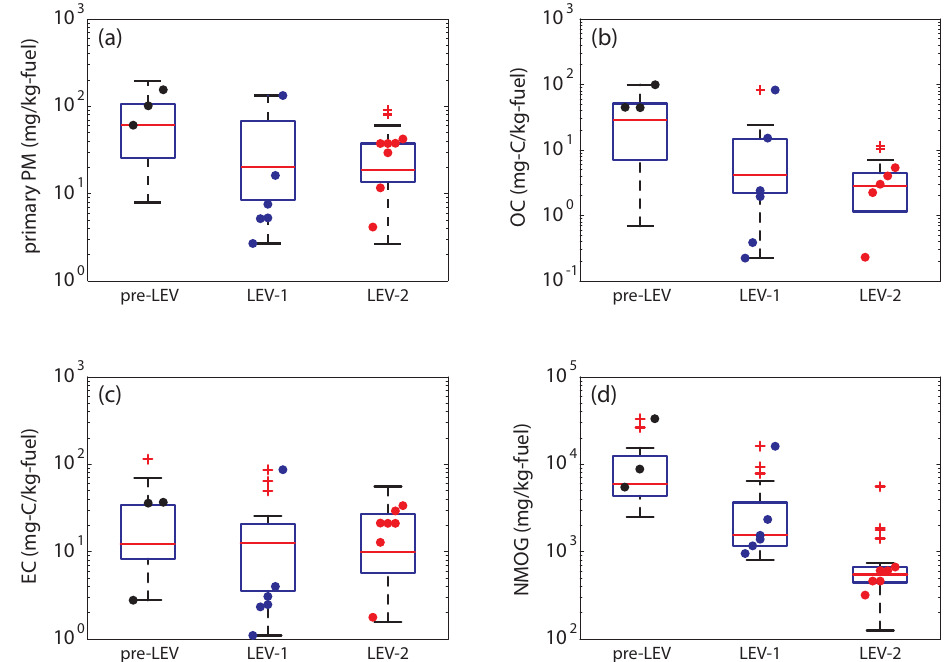
Fig. 2. Cold-start primary emissions from light-duty gasoline vehicles tested in the smog chamber shown as individual data points overlaying boxplots of the data from entire test fleet (May et al., 2014). The primary emissions are measured from the constant volume sampler (CVS): (a) total primary PM from gravimetric analysis, (b) OC and (c) EC components of primary PM from thermal-optical analysis of quartz filters and (d) nonmethane organic gases. The 15 chamber vehicles include 3 unique pre-LEV vehicles (black circles), 6 unique LEV1 vehicles (blue circles) and 6 unique LEV2 vehicles (red circles). The central marks on the boxplots are medians, the edges of the boxes are the 25th and 75th percentiles, the whiskers extend to the most extreme data points not considered outliers, and outliers ( > 1.5 × interquartile range) are plotted individually with the “ + ”